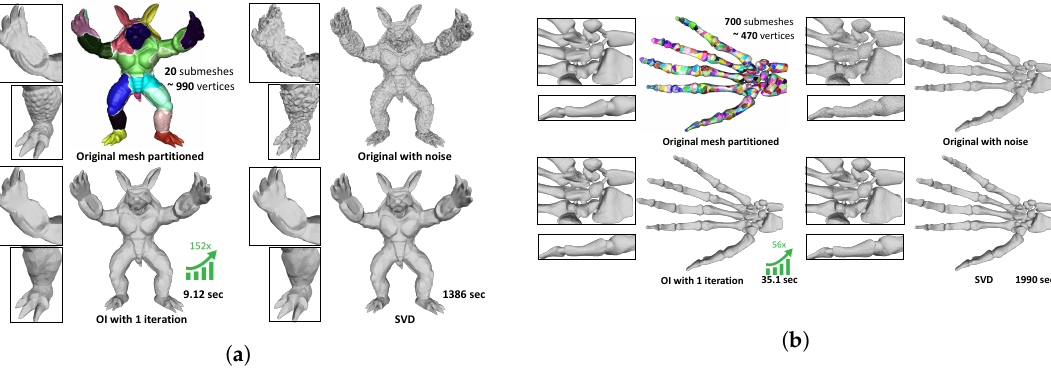
Figure 16. Filtering of 3D models ( a ) Armadillo (20,002 vertices) using c = 297 and ( b ) Hand (327,323 vertices) using c = 47 with noise: N ( 0,0.2 ) . Each color represents a submesh, and the arrow depicts the speed-up in execution time compared to